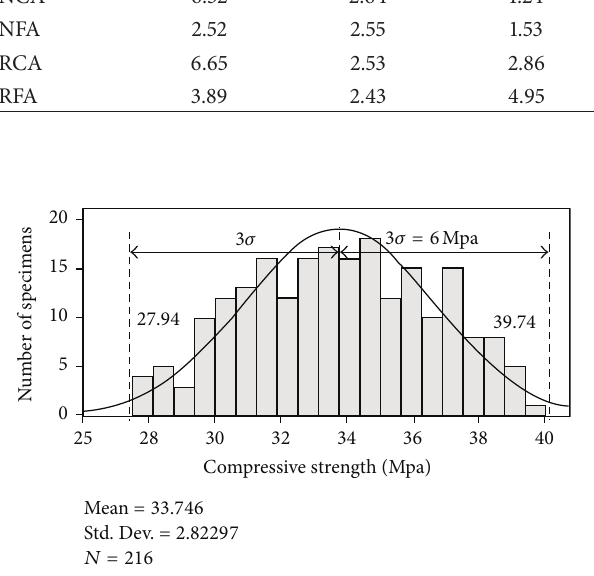
Figure 2: Histogram of compressive strengths of S/a : 42%, 47%, and 52%.